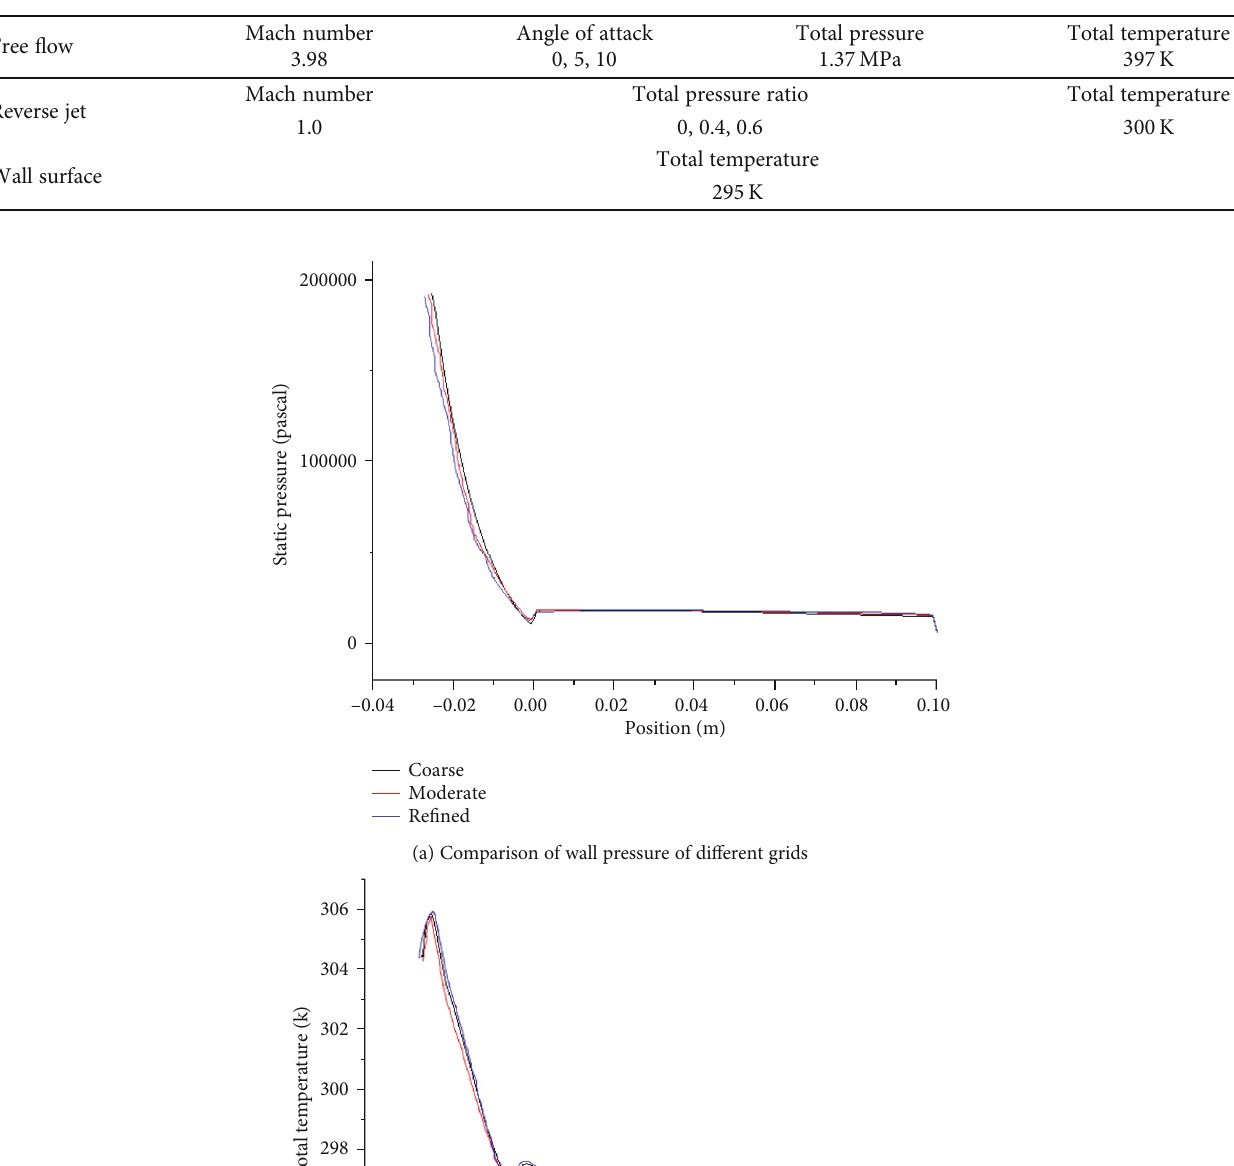
Table 1: Boundary conditions.